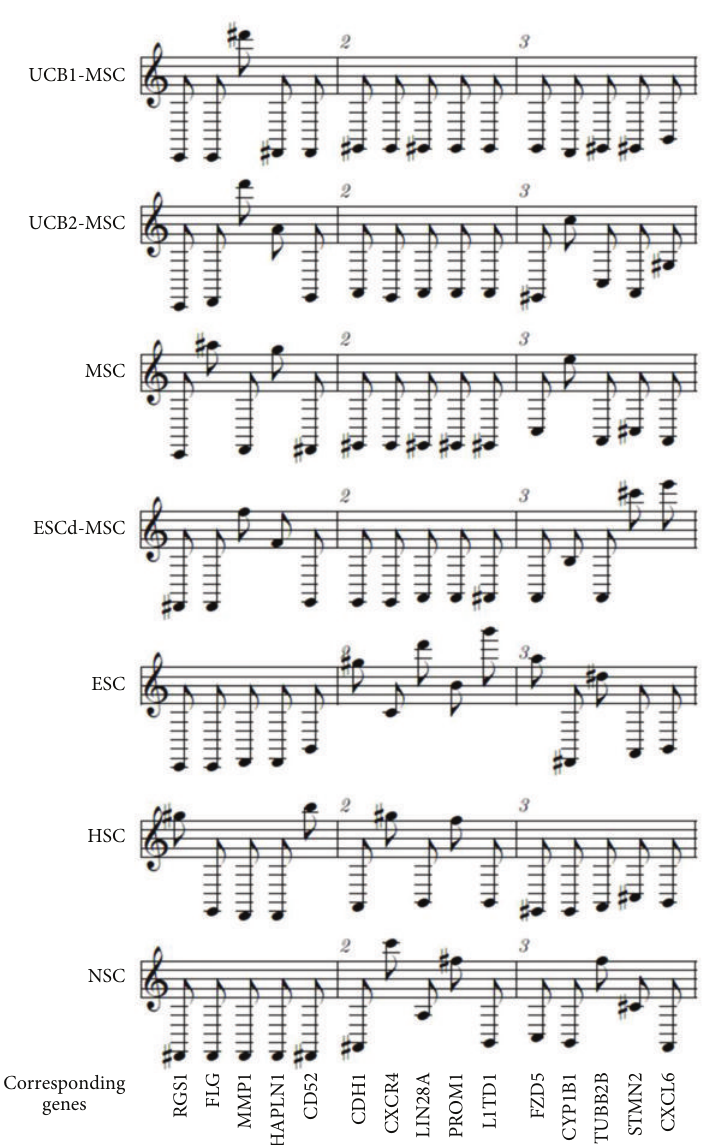
Figure 2: Stem cell melodies. DNA microarray cel files were processed as described in the caption of Figure 1. Presented are the first three bars from individual representative